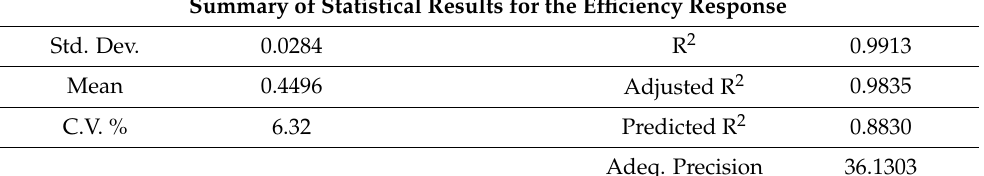
Table 5. Summary of statistical results for the efficiency response.